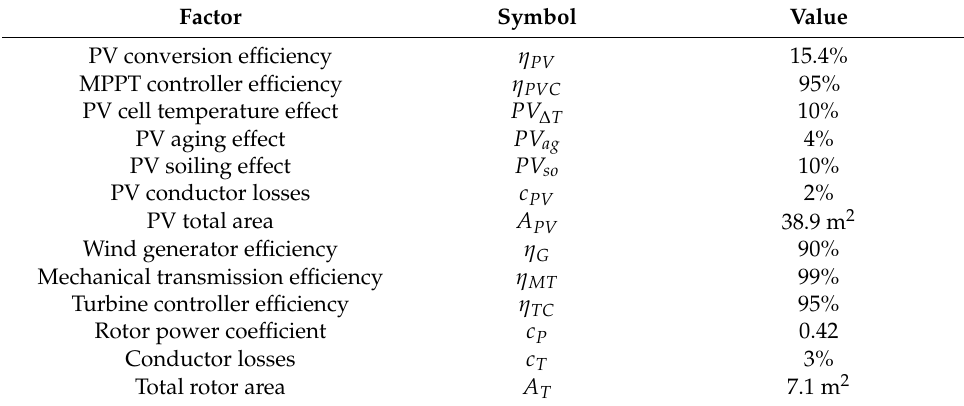
Table 3. PV and wind turbine performance